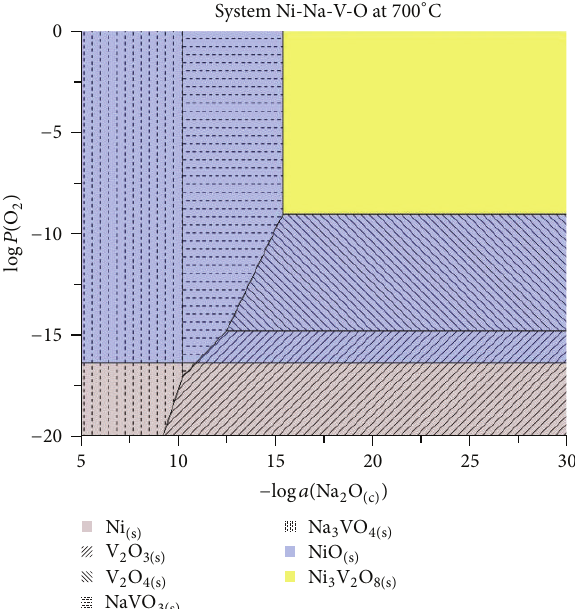
Figure 7: Thermodynamic stability diagrams for Fe-Na-V-O at 700 ∘ C.